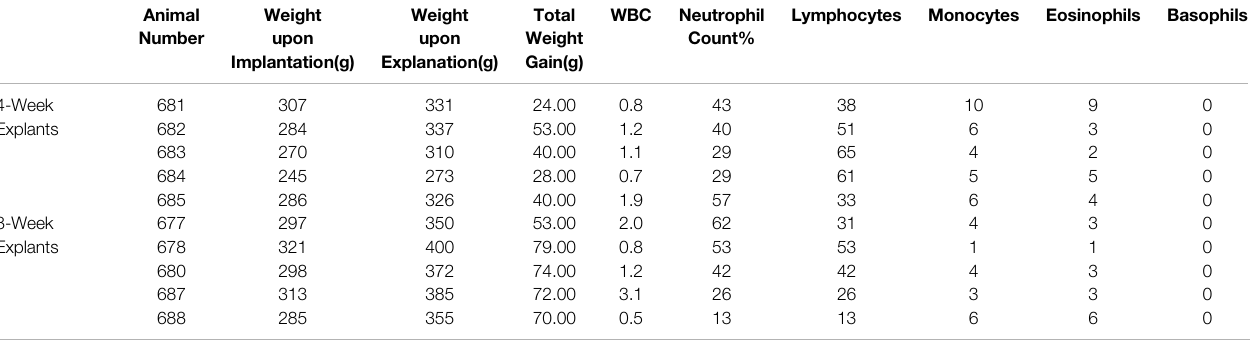
TABLE 2 | Circulating blood counts (CBCs) of each animal upon explant.